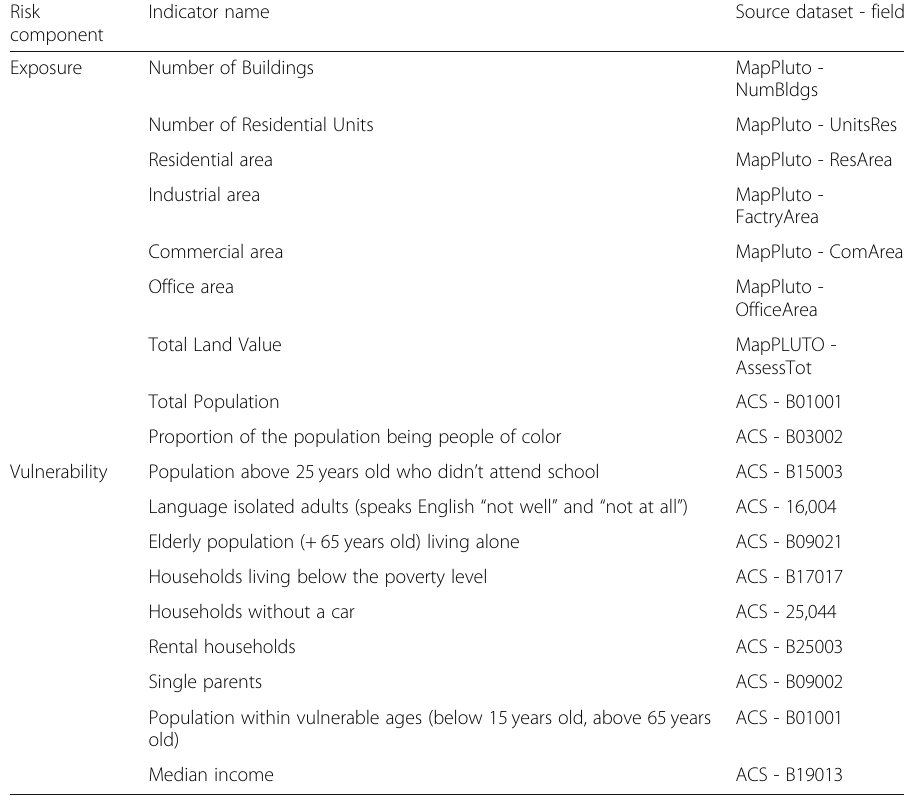
Table 5 Indicators used in the analysis of exposure and vulnerability changes across time and